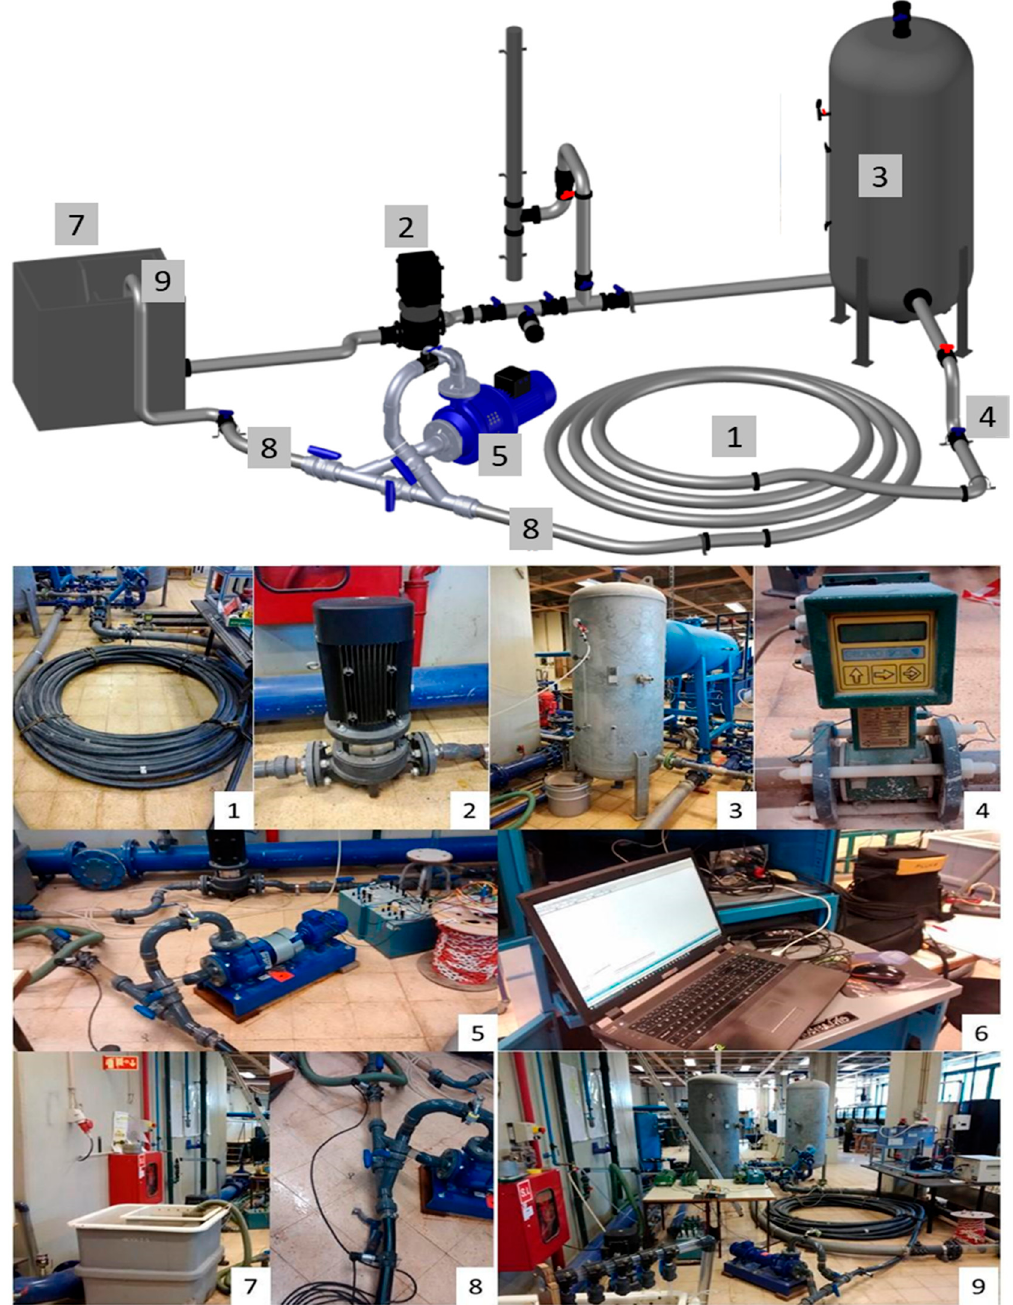
Figure 3. Experimental set-up of the PAT pilot station: ( 1 ) HDPE conduction; ( 2 ) recirculation pump; ( 3 ) air vessel; ( 4 ) flowmeter; ( 5 ) PAT; ( 6 ) picoscope and acquisition system; ( 7 ) regulation; ( 8 ) pressure transducers; and ( 9 ) hydrant.